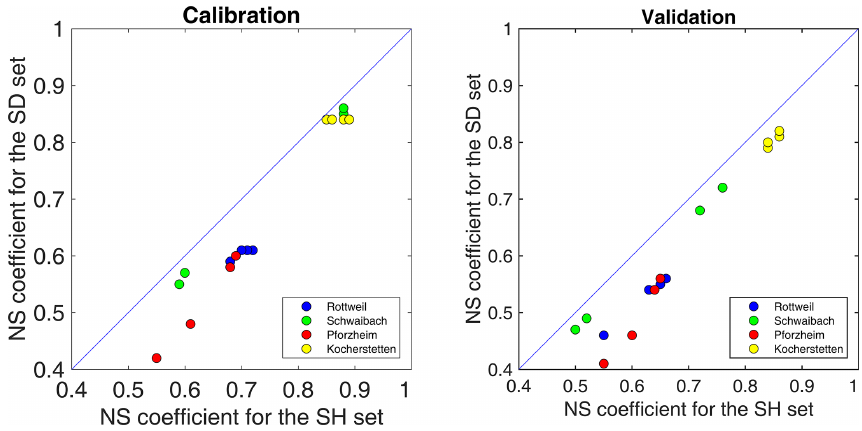
Figure 8. Comparison of the NS coefficient for using hourly and daily rainfall as model input for the SH and SD sets.